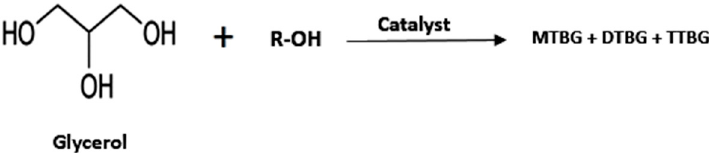
Scheme 4. Conversion of glycerol to glycerol ether using alcohols .